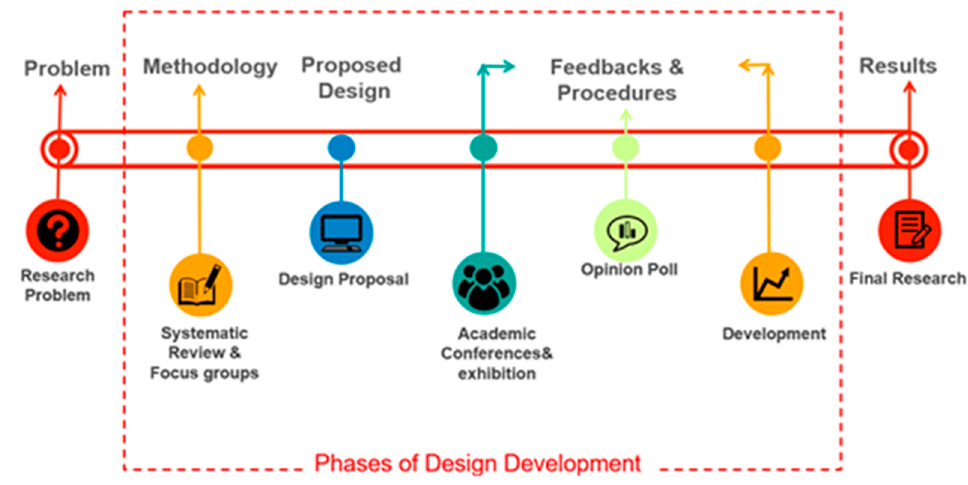
Figure 5. Sequential phases for the design development (diagram by the authors).